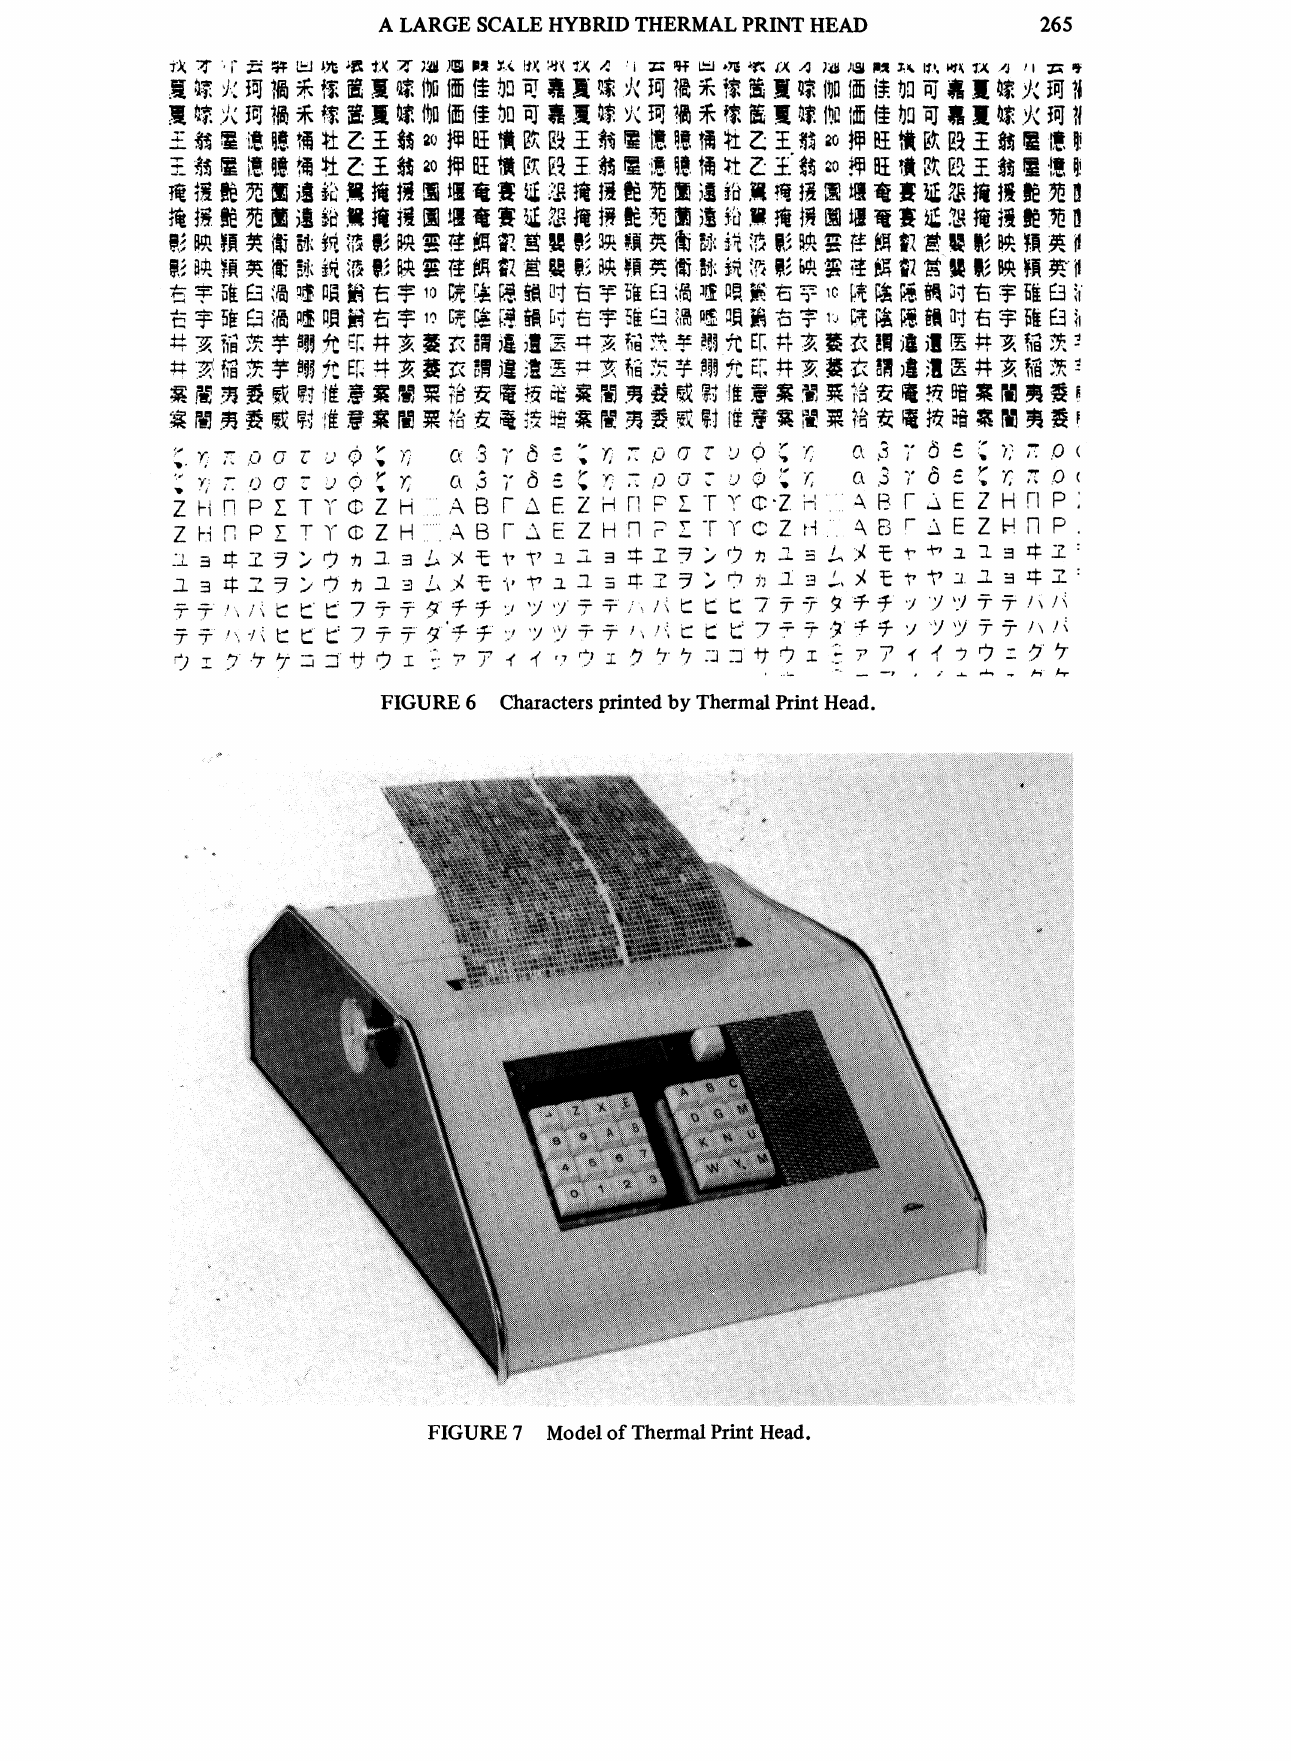
FIGURE 7 Model of Thermal Print